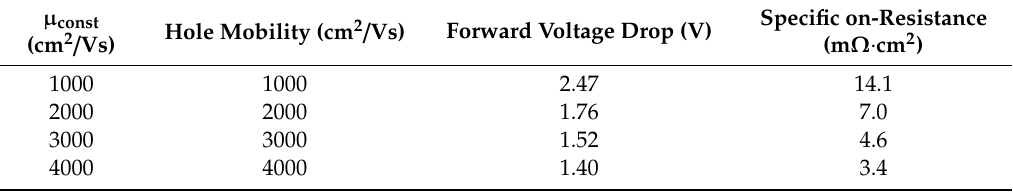
Table 1. Hole mobility, forward voltage drop ( V f ), and specific on-resistance ( R on,sp ) of the p-type diamond pseudo-vertical Schottky barrier diode (SBD) simulated using the constant mobility model with µ const of 1000, 2000, 3000, and 4000 cm 2 / Vs. The lattice temperature was 300